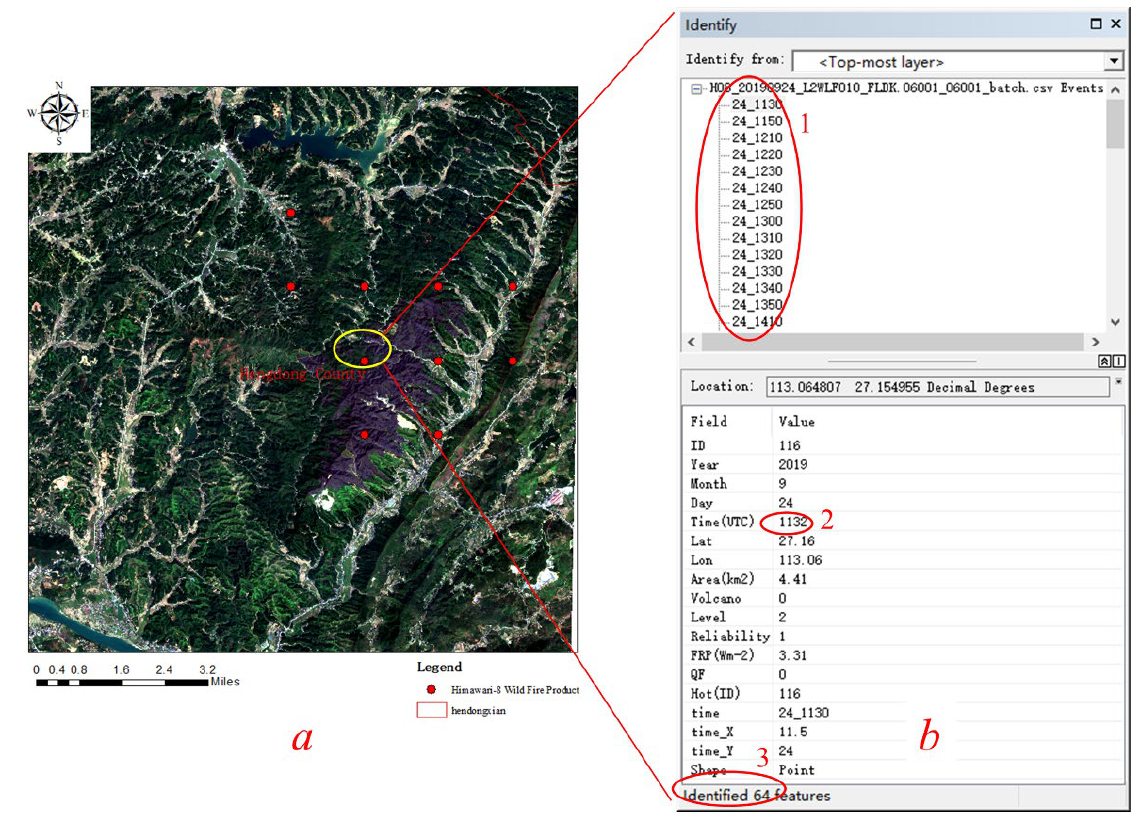
Figure 3. Determination of M-HWFP and preprocessed HLGD datasets pertaining to the time closest to a forest fire’s starting time in a target area. ( a ) Red points represent hotspots derived from the HWFP data. ( b ) UTC times when the forest-fire events were detected by Himawari-8 satellite are shown in the first red circle; the earliest UTC times when the forest-fire events were detected by Himawari-8 satellite are shown in the 2nd red circle; the number of times a forest-fire event was detected in a day is shown in the 3rd red circle.